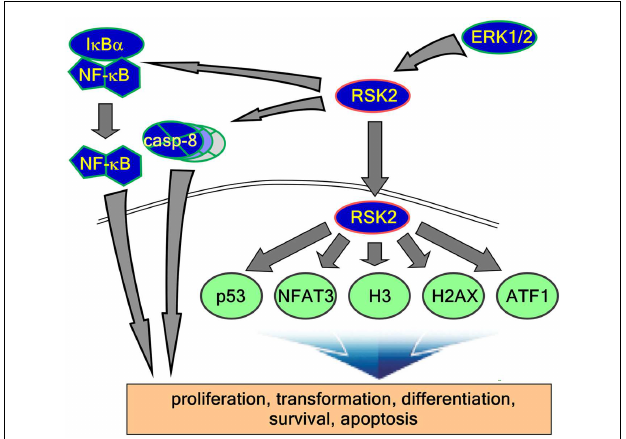
FIGURE 2 | RSK2 substrates and function of signaling axis . Activated RSK2 by ERK1/2 transfers the phospho-signal to I κ B α and caspase-8, results in the regulation of inflammation and apoptosis. On the other hand, activated RSK2 localizes into the nucleus and phosphorylates their substrates such as p53, NFAT3, histone H3, histone 2AX, ATF1, and other substrates.Taken together, these functional signaling pathways regulate diverse biological activities including cell proliferation, transformation, differentiation, survival, and cancer